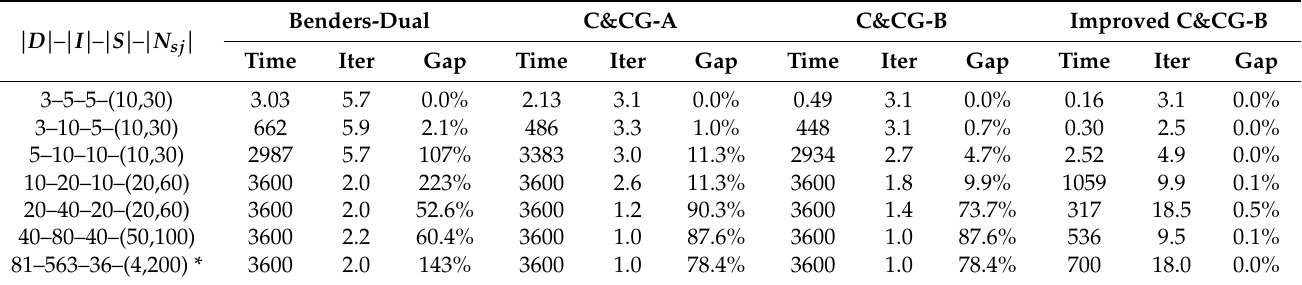
Table 3. Computational performance comparison. *: Real